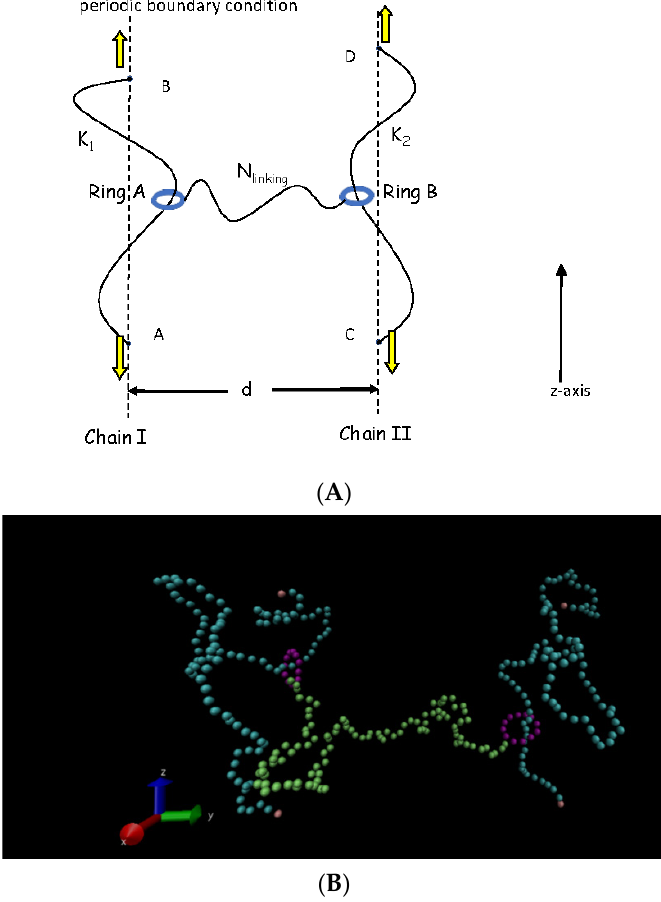
Figure 1. ( A ) Schematic diagram of a simple slide-ring gel in which two ring chains are linked by a flexible linear chain with the chain length N linking and two ring chains slide along two axial chains with different bending energies of K 1 and K 2 as well as the distance of two parallel axial chains is d. Points A, B, C and D are fixed, and the line AB is parallel to the line CD [13,18]. ( B ) A real snapshot of simulation system by using visual molecular dynamics (VMD) for ring chains sliding along the symmetric fluctuating axial chains [25].